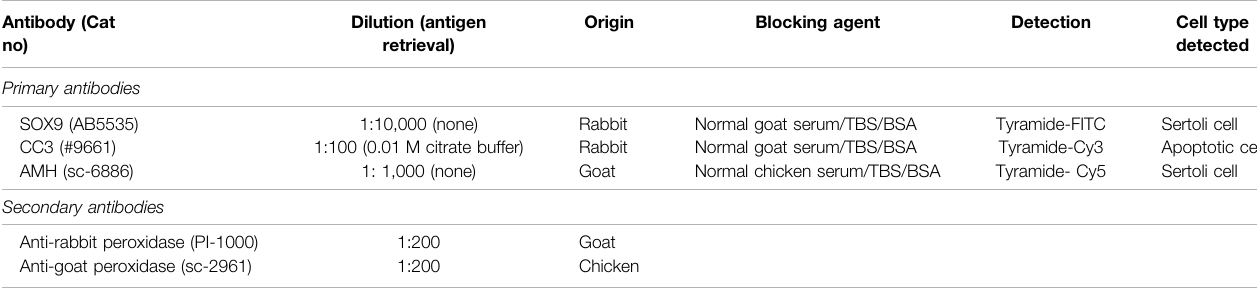
TABLE 2 | Key reagents used in immuno fl uorescent protocol. Antibody (Cat